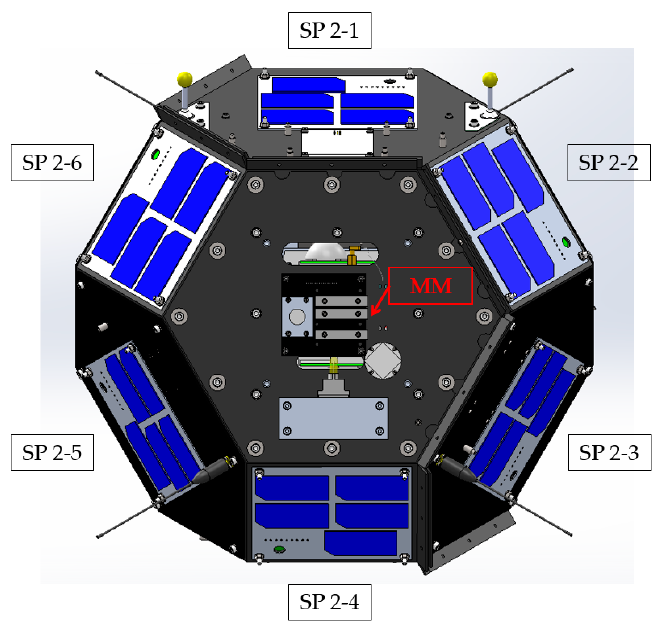
Figure 12. Location of six solar panels (SP) near to MM.